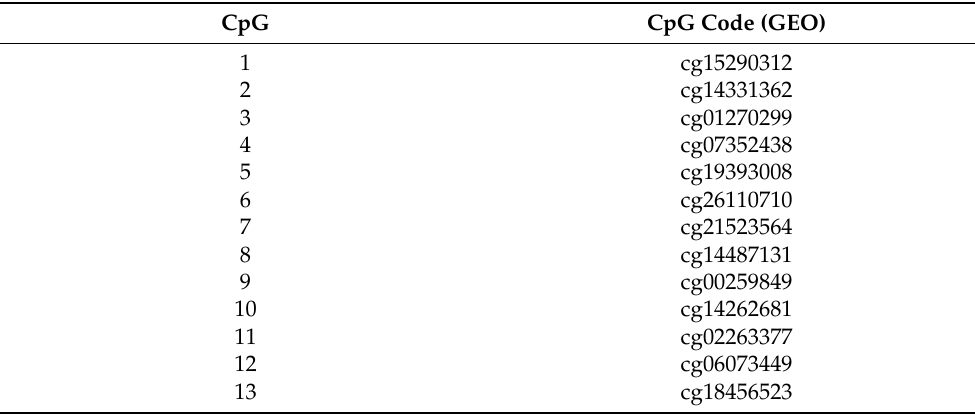
Table A1. CpG obtained using Algorithm